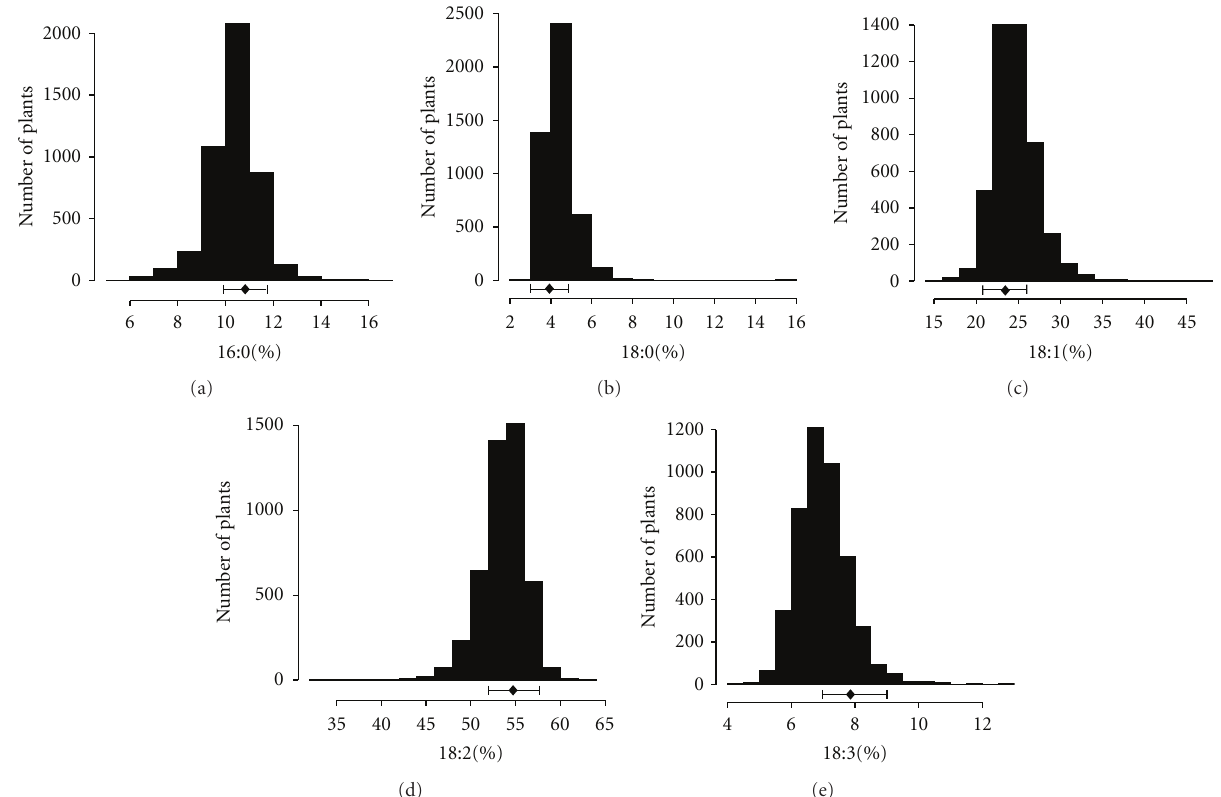
Figure 1: Distribution of fatty acid levels in the mutant population. Percentage of each fatty acid as measured over 4566 M 3 seed samples from mutant M 2 individuals by gas chromatography for five major fatty acids of soybean seeds. Black diamond on x -axis represents mean fatty acid level for Williams-82 wild type, and error bars represent two standard deviations from the mean. (a) 16 :0 Palmitic acid, (b) 18:0 stearic acid, (c) 18 :1 oleic Acid, (d) 18 :2 linoleic acid, and (e) 18:3 linolenic